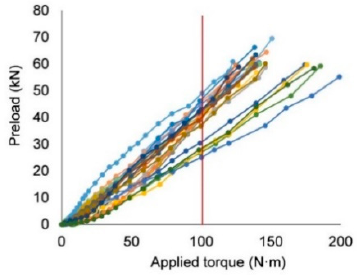
Figure 5. Relationship between externally applied torques and measured preloads.